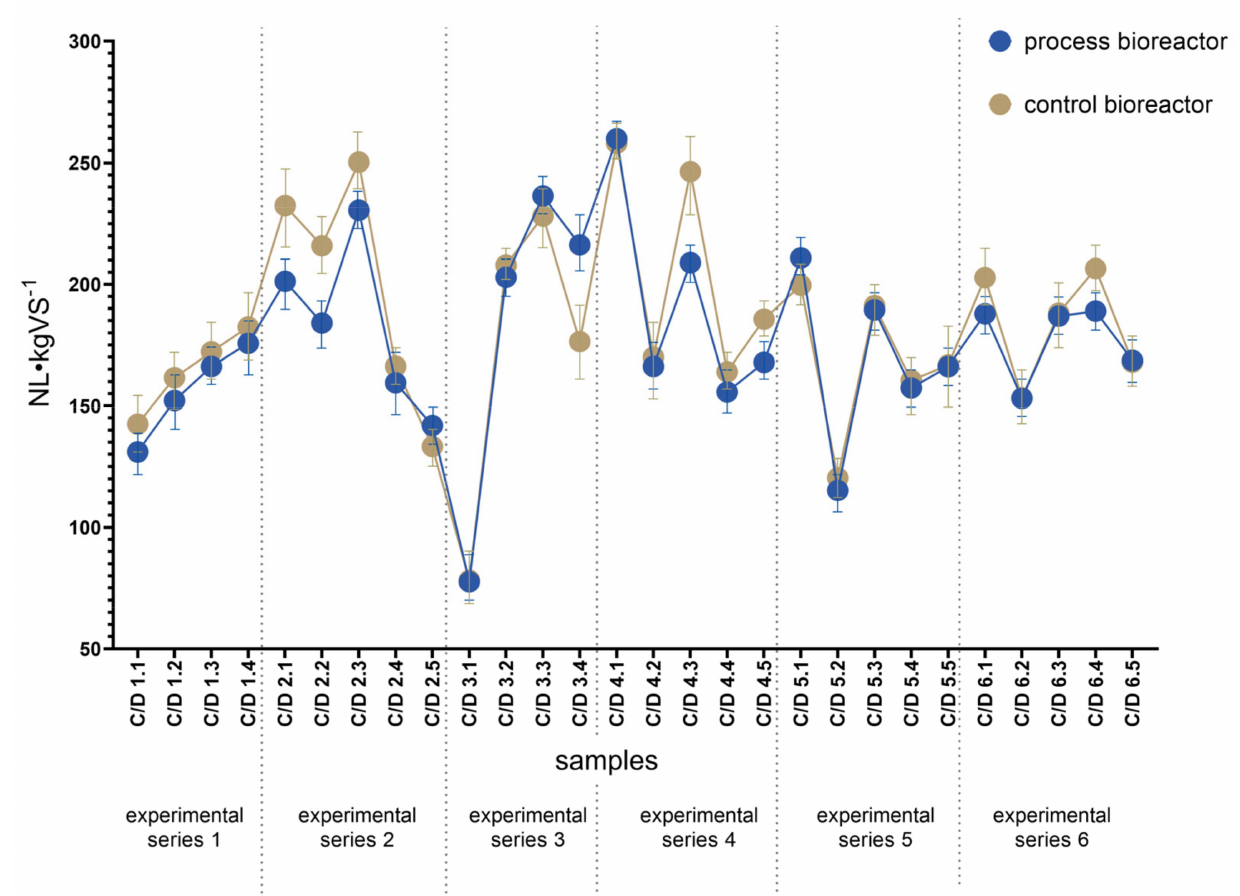
Figure 1. Methane production (NL · kgVS − 1 ) in the process and control bioreactors. C-control samples, D-dose ID. For example, “C/D 1.1” indicates samples C1.1 and D1.1 (green and blue points on the line graph,